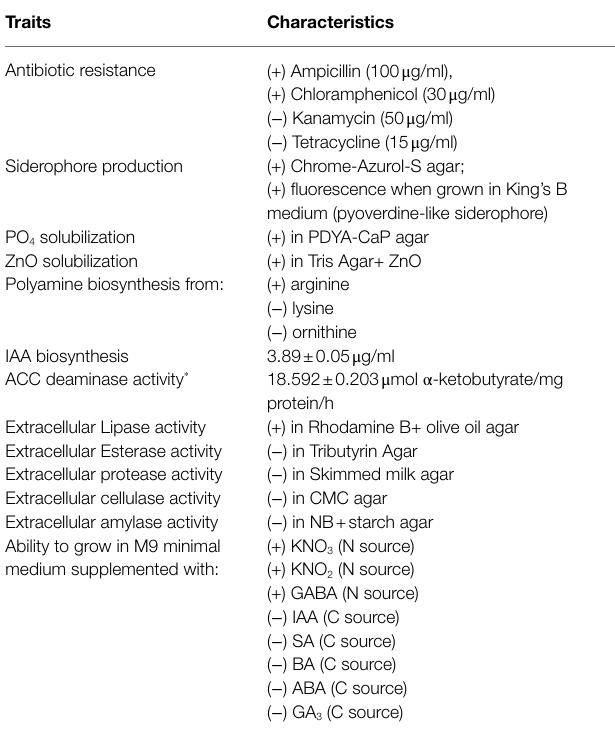
TABLE 1 | Phenotypic characterization of P. thivervalensis SC5.